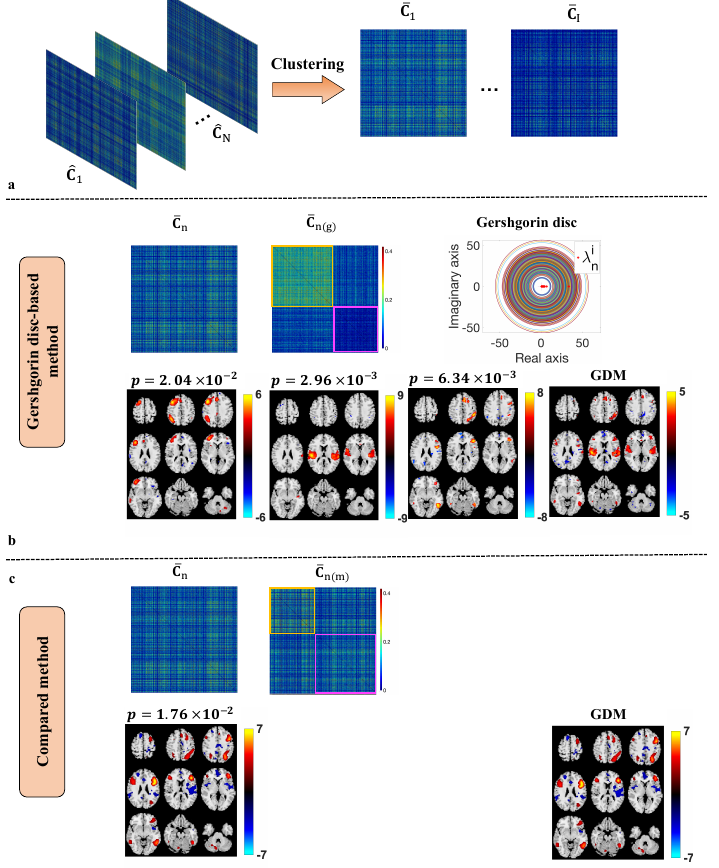
Figure 4. Performance comparison between the Gershgorin disc-based method and the compared method in [34] on the aggregated matrix ¯ C . The process of clustering SCVs with similar activation patterns into the same cluster, resulting aggregated covariance matrix ¯ C is displayed in ( a ). The identified subgroups and the corresponding t-maps from the Gershgorin disc-based method and the compared method in [34] are shown in ( b , c ) separately. Subgroups 1 and 2 are denoted by yellow and magenta squares separately. Subgroups from both methods show significant activity differences in meaningful brain areas such as the dorsolateral prefrontal cortex (dlPFC), anterior cingulate cortex (ACC), etc. The Gershgorin disc-based method provides more meaningful brain areas that show significant group differences and the subgroups that form better block structures in the aggregated covariance matrix as is shown in ¯ C n ( g ) than the one formed by the compared method in ¯ C n ( m ) . As it is shown in Figure 4, Gershgorin disc-based approach reveals a better subgroup structure than the method in [34] as the block structure is more obvious in the Gershgorin disc-based result. This can be explained by the nature of the Gershgorin disc-based method that takes the eigenspectrum of ¯ C into consideration. The statistical tests on neuroimaging and cognitive variables also show more significant group differences with the Gershgorin disc-based method results. Three neuronetwork components that show significant group differences are found by the Gershgorin disc-based method versus one component by the method in [34]. We investigate the cognitive scores by applying MANOVA to each set of tests. The MANOVA results for the Gershgorin disc-based method are F -score = 4.95 ( p = 1.5 × 10 − 4 ) for BACS, F -score = 5.3 ( p = 7.21 × 10 − 6 ) for SFS, and F -score = 7.57 to assess differences between the subgroups. The identified subgroups from the